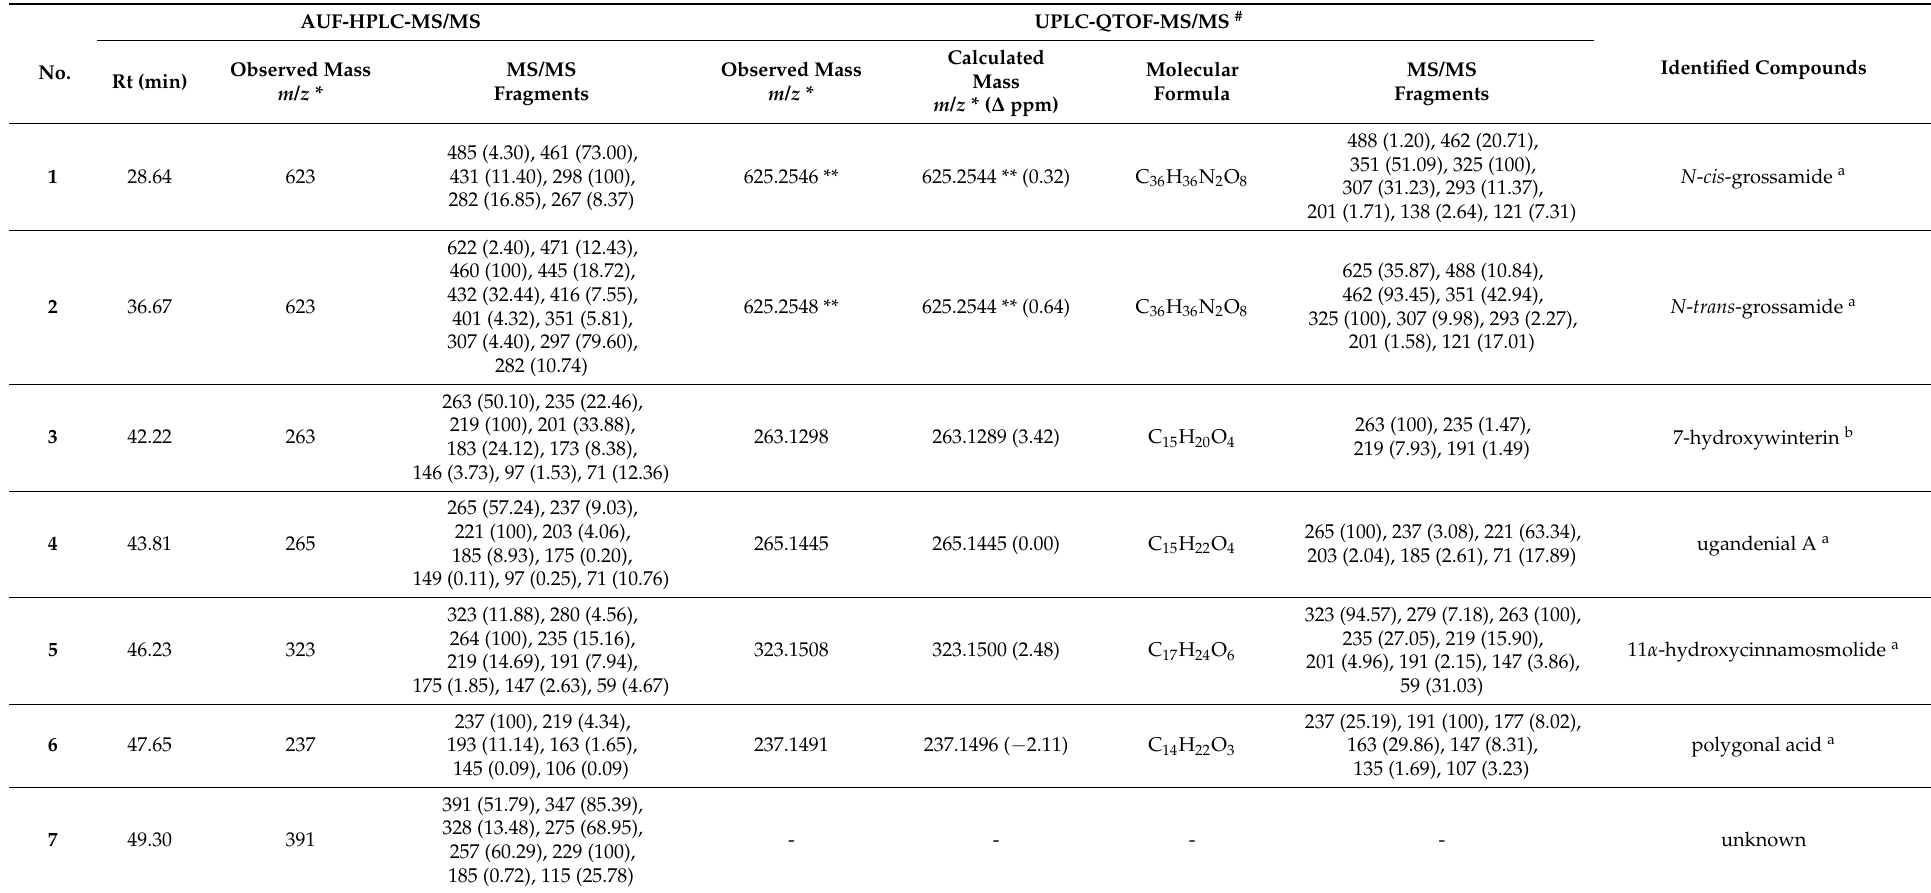
Table 2. The identification of corresponding peaks in Figure 2 in WE-P from W. ugandensis using HPLC-MS/MS and